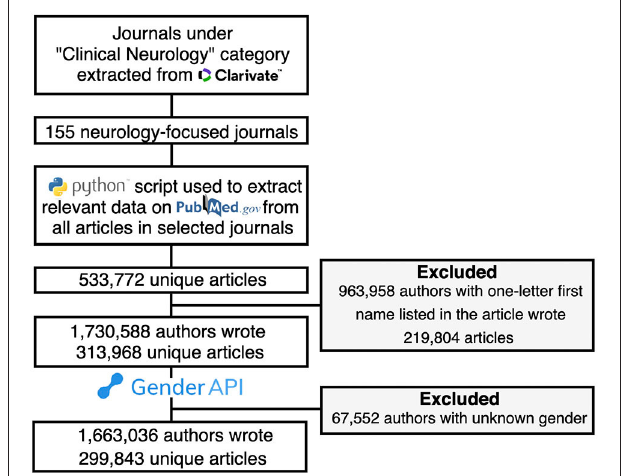
FIGURE 1 | Study flowchart. The logos are from the company websites: Clarivate (https://clarivate.com/), Python (https://www.python.org/), PubMed (https://pubmed.ncbi.nlm.nih.gov/) and Gender API